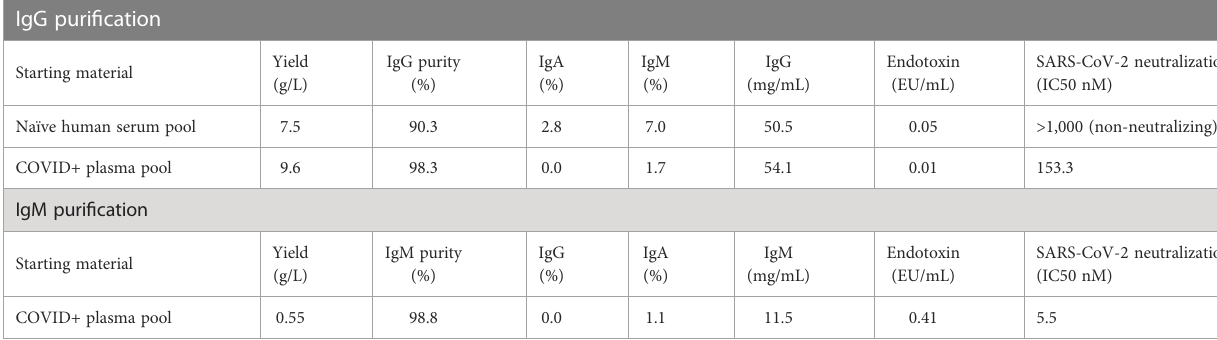
Table 1 Characteristics of puri fi ed IgG and